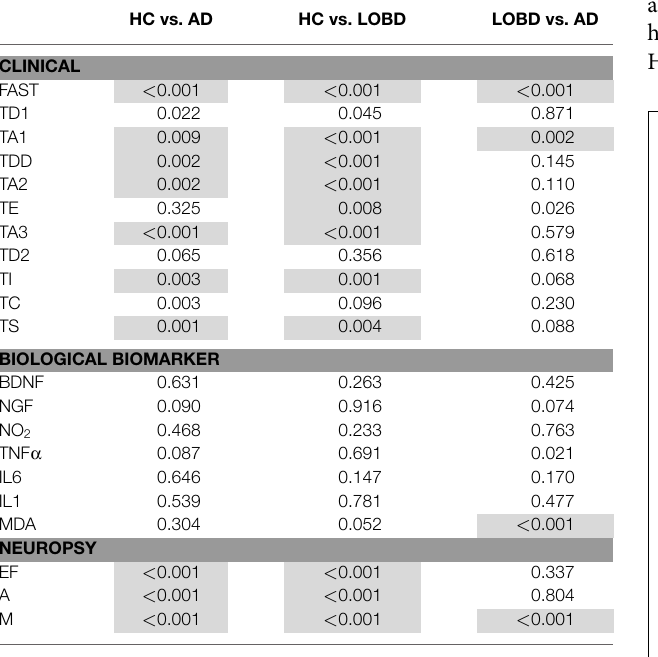
TABLE 2 | Welch’s t -test p -value for each behavioral, biological biomarker, and aggregate neuropsychological variable (rows) per group contrast (columns) .